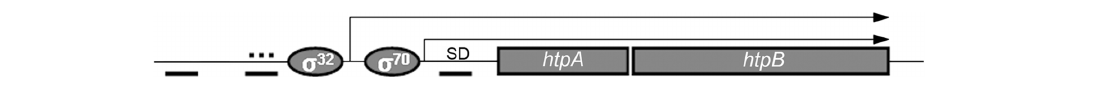
and the housekeeping σ 70 promoter.The dotted thick line represents an UP element, and the solid thick lines represent integration host factor binding sites. SD, Shine–Dalgarno sequence.The regulatory mechanism that controls the expression of the htpAB operon is not well